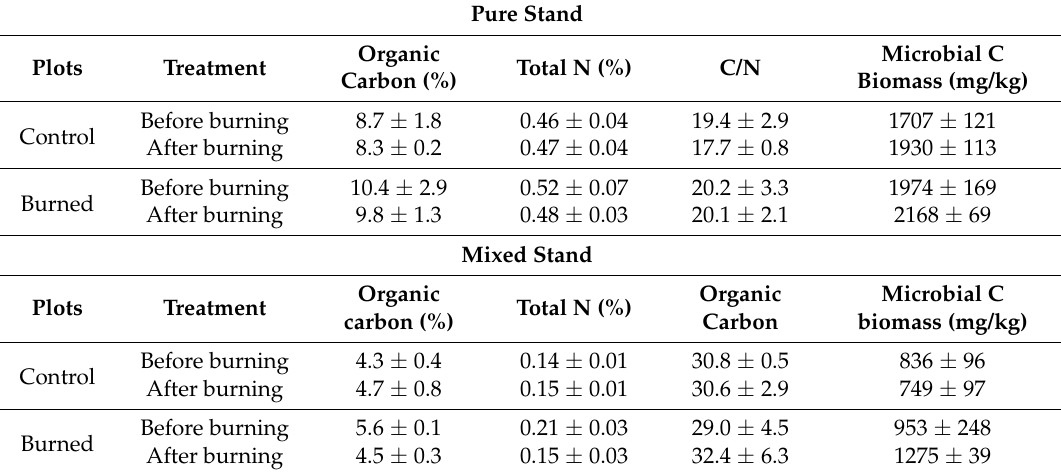
Table 3. Soil characteristics for each site before and after the prescribed fire treatment. Mean values and standard deviations. There were no significant differences ( p < 0.05) before and after burning for each stand type. Pure